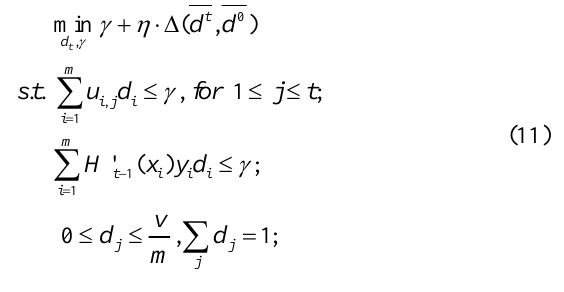
a new weak classifier